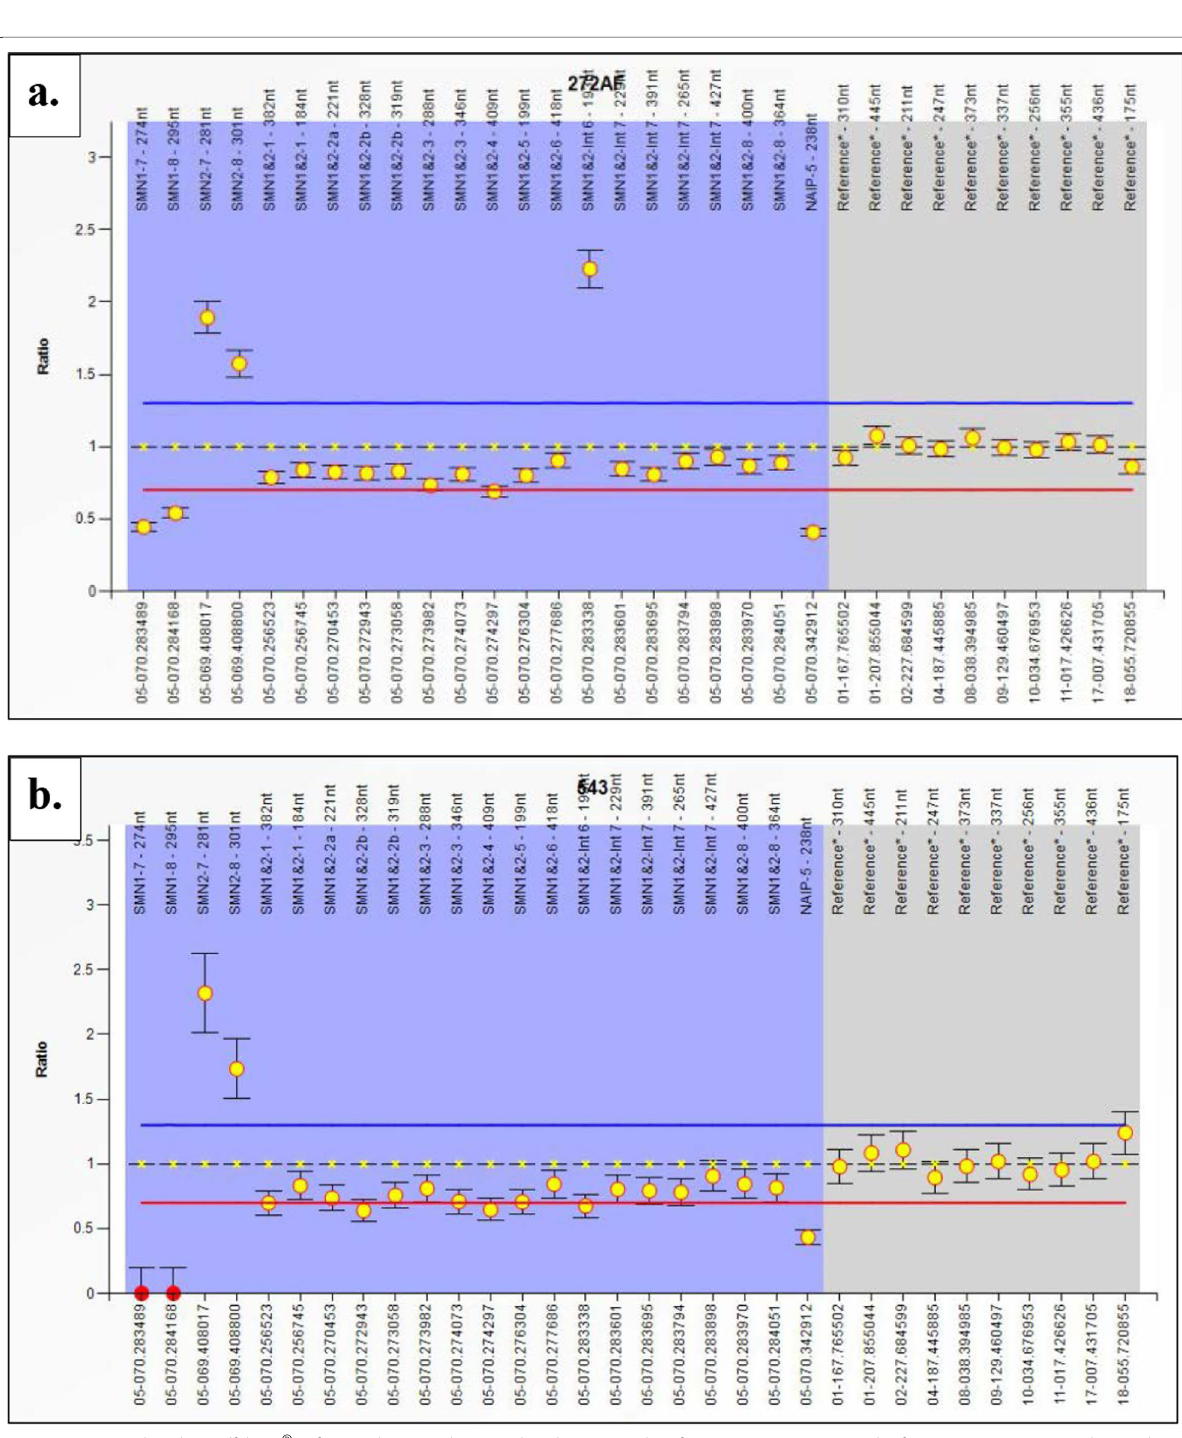
Fig. 1 MLPA analysis by Coffalyser ® software showing the tested probes (32 probes for SMN1, SMN2, NAIP and reference genes) against the median values ratios detected in three amniotic fluid samples from different three families (Normal range: 0.7—1.3). a Heterozygous deletion of exons 7 and 8 of SMN1 in amniotic fluid sample AF5. b Homozygous deletion of exons 7 & 8 of SMN1 in asymptomatic parent of special case family (Family 53). c Normal copies of SMN1 gene in amniotic fluid sample